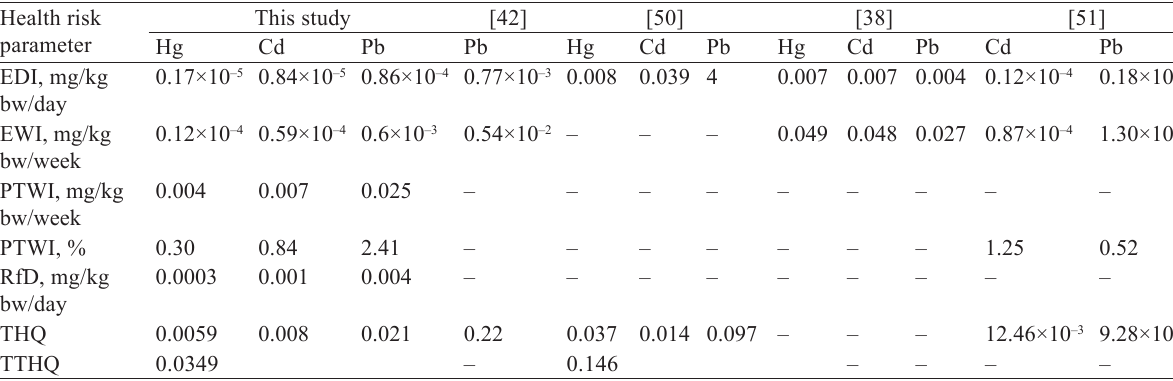
Table 3 Health risk parameters for the Iranian population consuming farmed rainbow trout cultured in Yasuj compared to